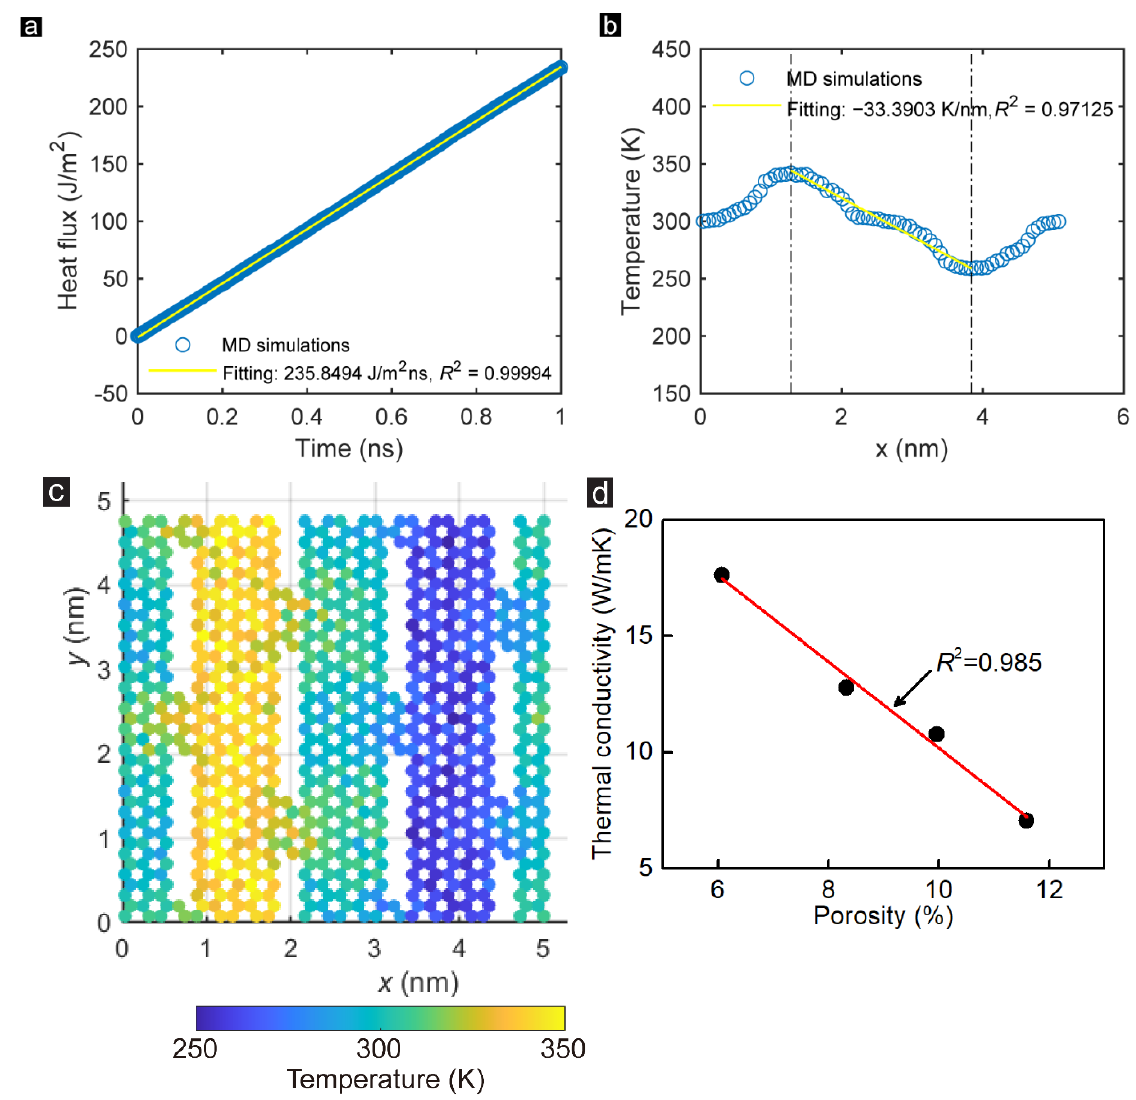
Figure 3. ( a ) Fitting results of the heat flux on the monolayer GK of Sample ZZ_1_1 within one nanosecond. ( b ) Time-averaged temperature distribution of each atom along the direction perpen- dicular to the GK incisions during the simulation. ( c ) Snapshots of the temperature distribution of Sample ZZ_1_1 after one nanosecond of heat conduction. ( d ) Relationship between the DD and the thermal conductivity on the zigzag-incised GK in Group_1.